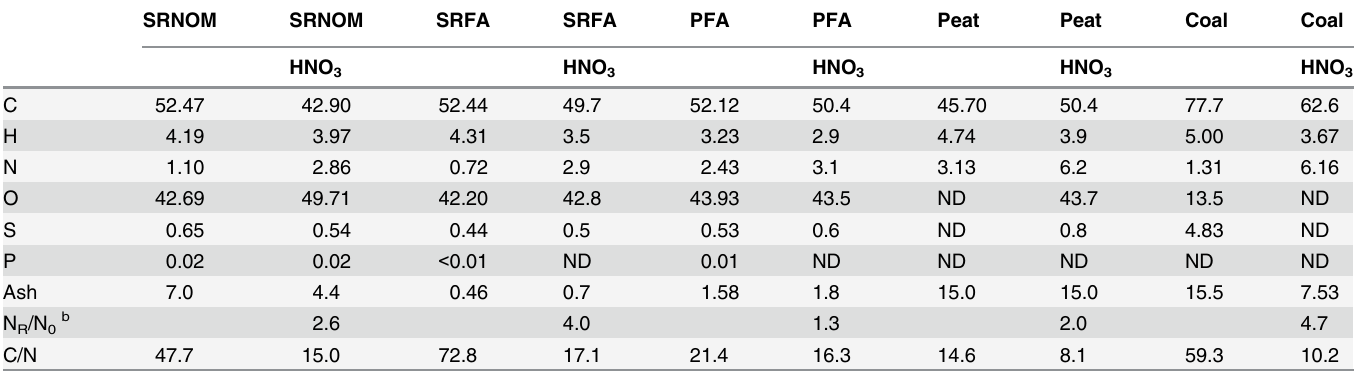
Table 1. Elemental analyses for NOM samples before and after nitric acid treatment a .